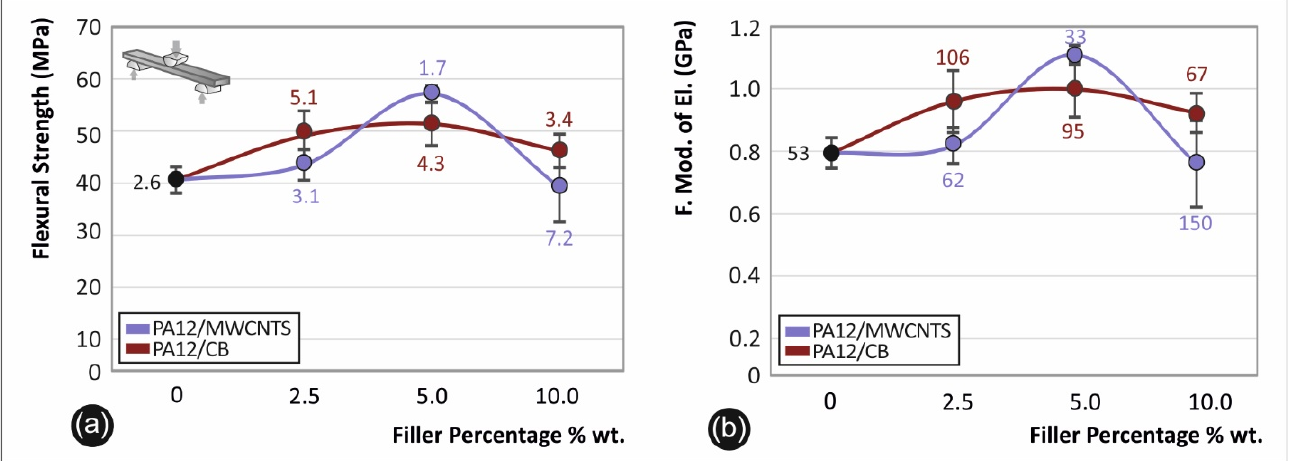
Figure 13. ( a ) Flexural strength average values along with the calculated standard deviation and ( b ) average flexural modulus of elasticity values; both as a function of the different filler loadings for the PA12/MWCNT and PA12/CB nanocomposites, respectively.